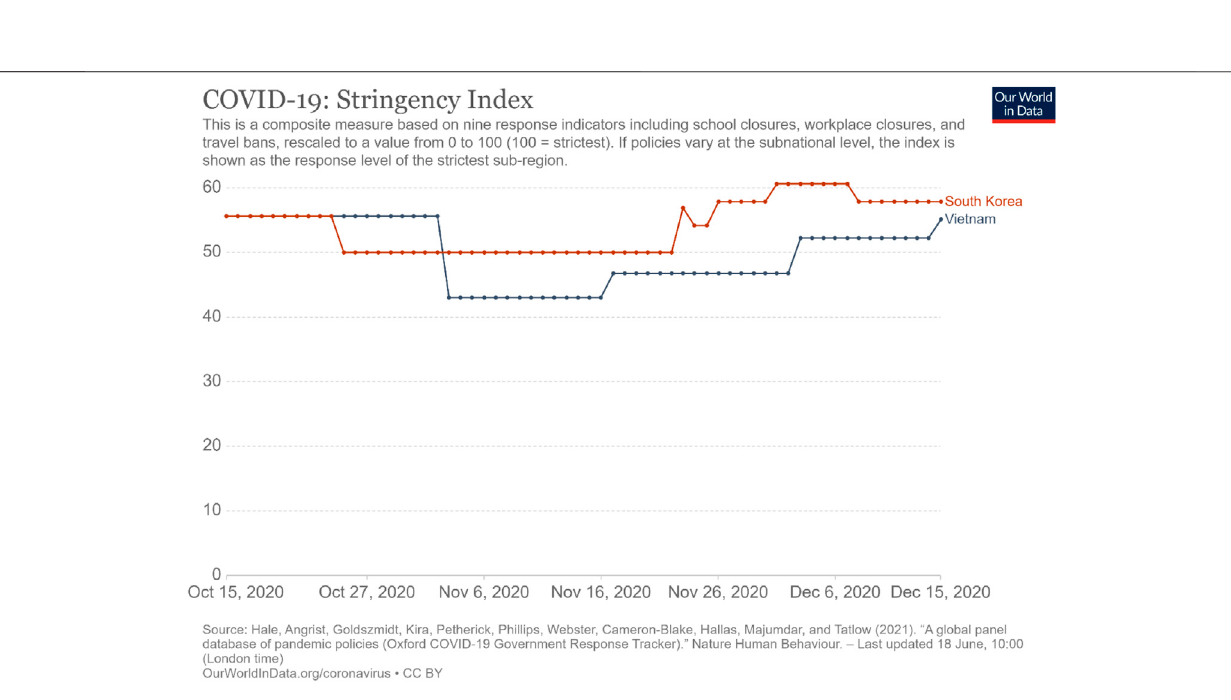
Frontiers in Communication |